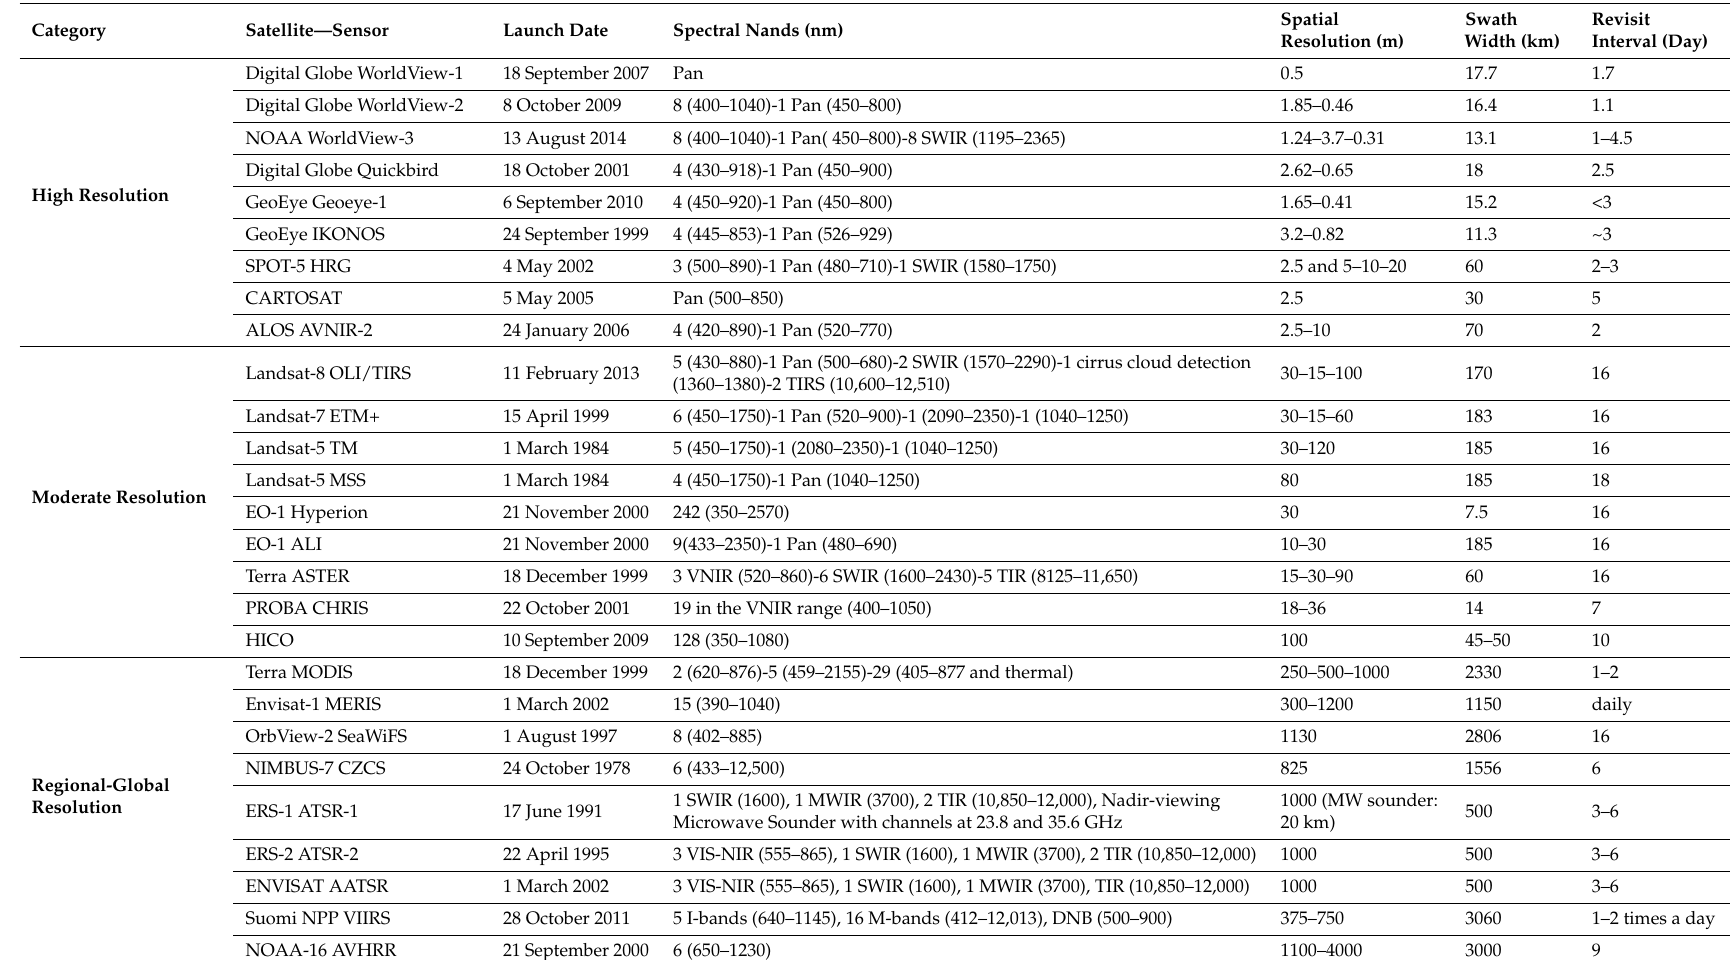
Table 1. List of the more commonly used spaceborne sensors in water quality